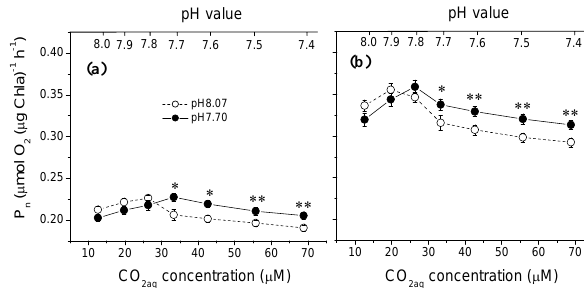
Figure 4. Net photosynthesis of P. globosa cells, acclimated to ei- ther pH8.07 or pH7.70 cultures in the corresponding irradiances to the measurement for 3 days (nine generations), under irradiances of (a) 25 and (b) 200µmol photons m − 2 s − 1 at different pH levels induced by different CO 2aq concentrations. The data represent the means ± SD in triplicate incubations. ∗ and ∗∗ indicate significant differences between the two pH levels at p < 0 . 05 and p < 0 . 01,